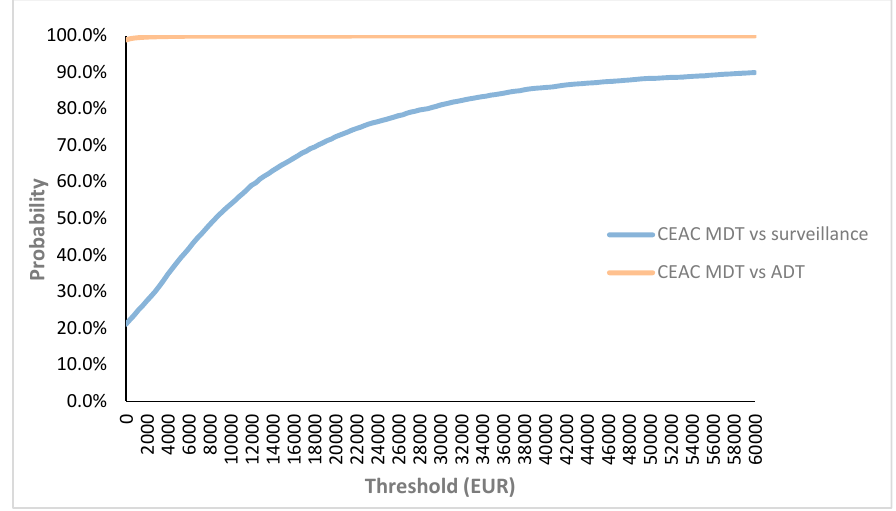
Figure 1. Probabilistic sensitivity analysis-cost-effectiveness acceptability curve. Please remark that the patients in the different groups (i.e., MDT, surveillance and ADT) entered different health states during follow-up and thus the corresponding costs and utilities of that health state were applied. Abbreviations CEAC: Cost-effectiveness acceptability curve; MDT: Metastasis-directed therapy.